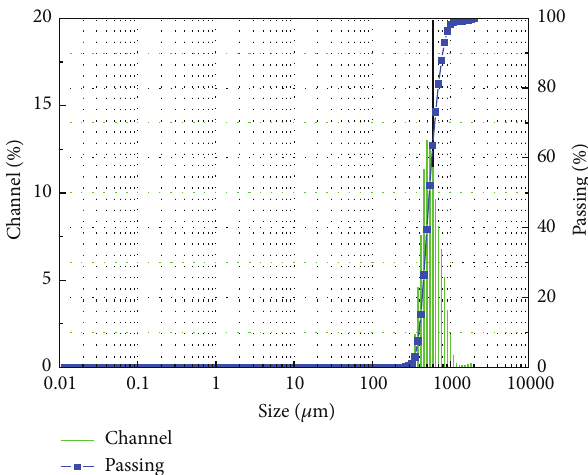
Figure 1: Particle size distribution of waste tire-rubber powder.